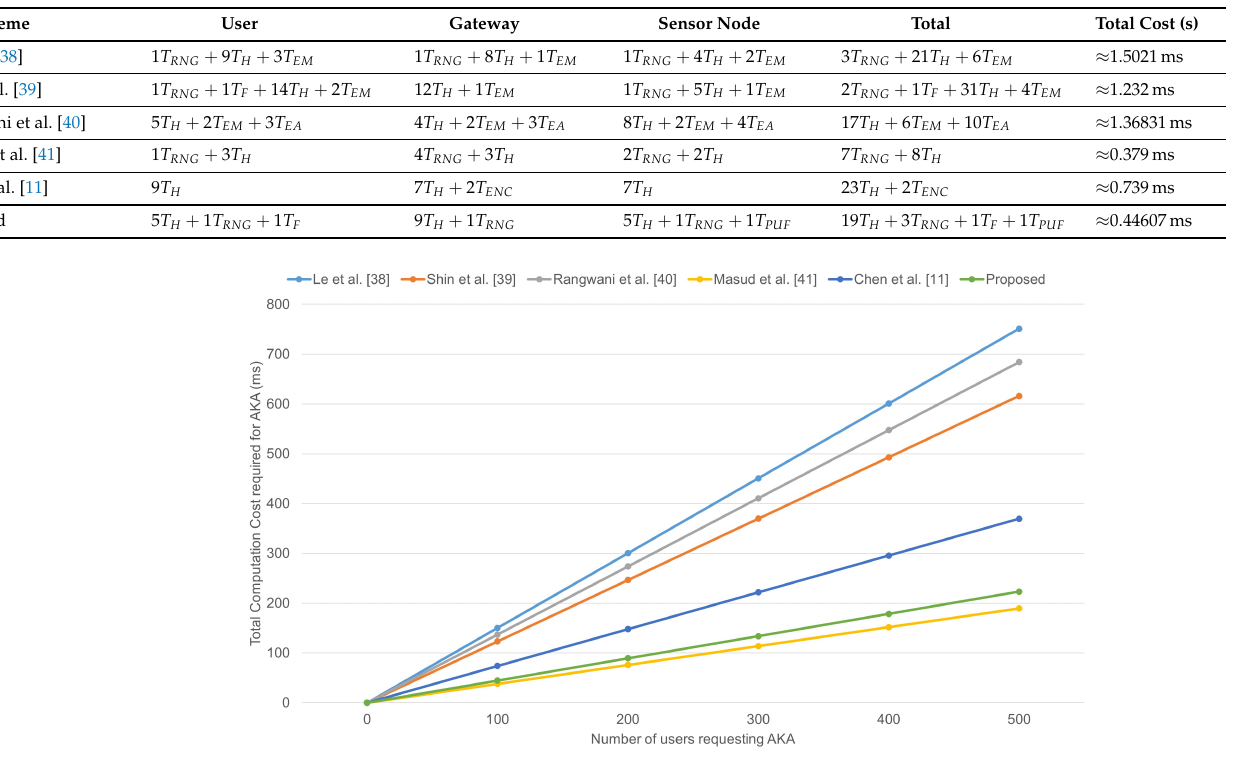
Figure 13. Total computation cost with increasing the AKA requests